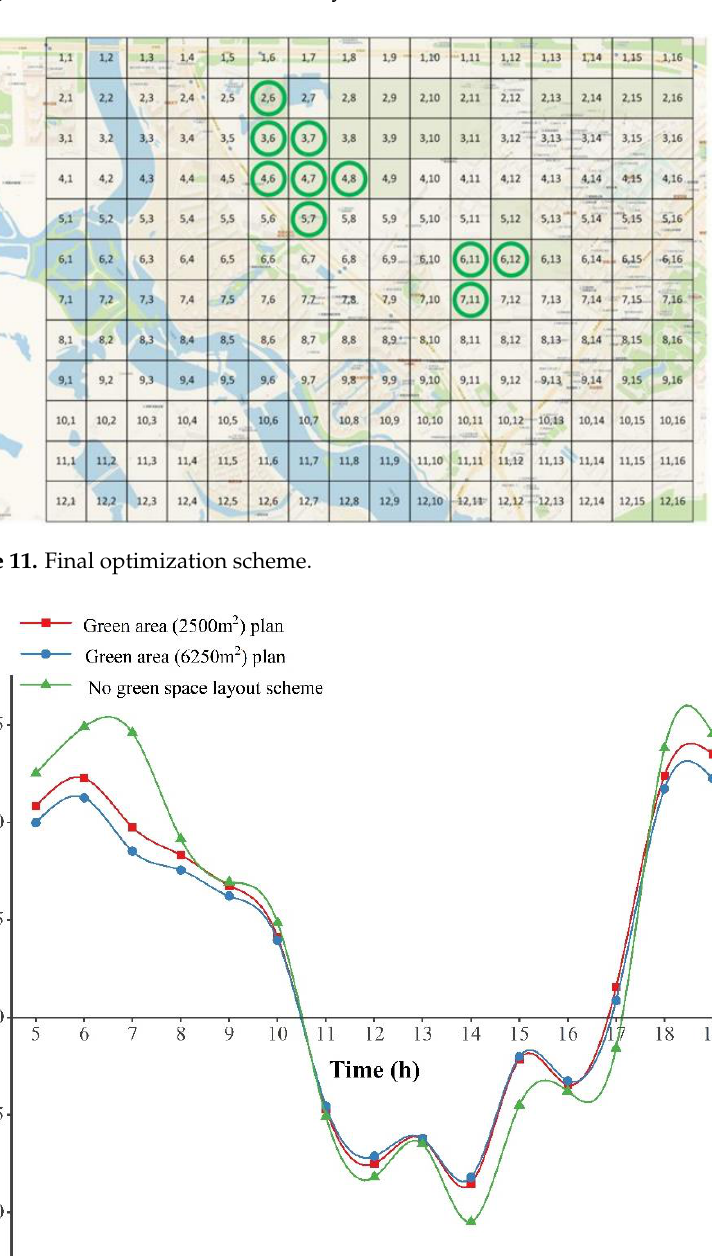
Figure 12. Mitigation effects curve of increasing green space layout area on heat island.